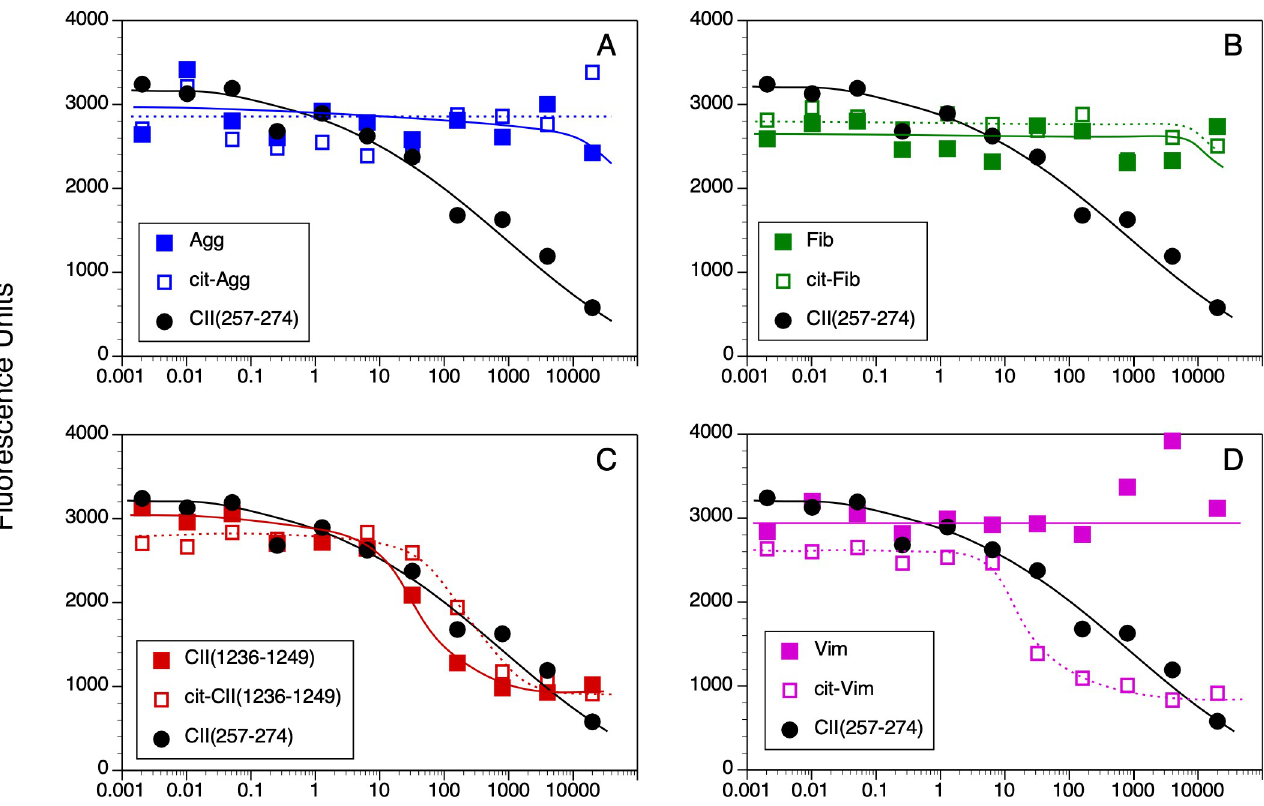
Fig 2. Measurement of peptide binding to DRB1 � 04:01. 10 nM of soluble DR4 was incubated for 18 h at 37˚ C with 0.5 nM of biotinylated CII(257–274) peptide and various concentrations of WT and Cit-peptides as competitors. Bound peptides were separated from free peptides by immobilizing the DR molecules with an antibody on microtiter plates. Bound biotinylated peptide was detected by incubation with streptavidin-europium. Time resolved fluorescence was quantitated and data are expressed as relative fluorescence units measured. Each binding assay was performed in duplicate, and data are representative of 3